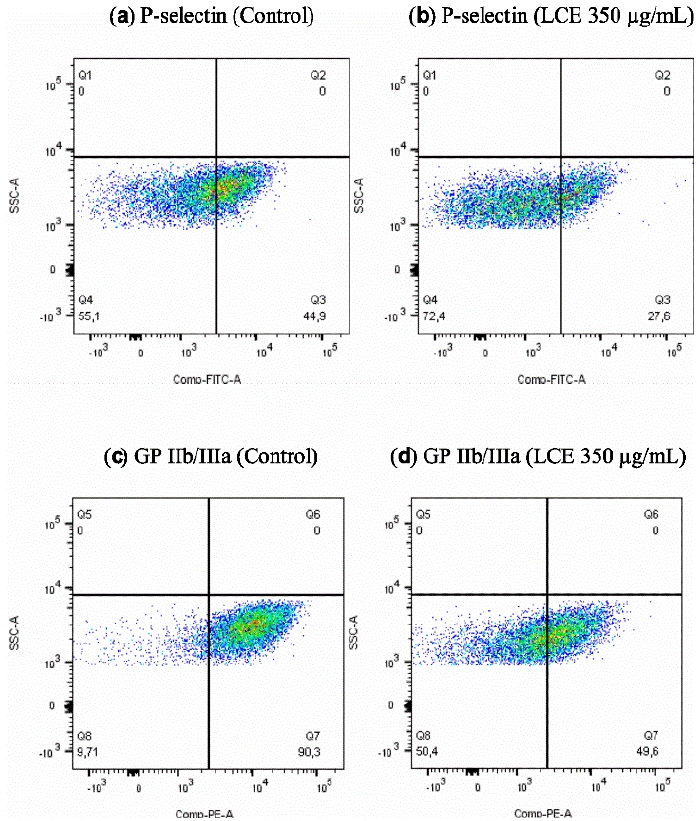
Figure 8. Representative dot plots for flow cytometry analysis. ( a ), ( c ) Control: P-selectin and GP IIb/IIIa expression on platelet surface after ADP activation. ( b ), ( d ) P-selectin and GP IIb/IIIa expression on platelet surface after ADP activation preceded by platelets co-incubation with L. cardiaca L. extract (LCE) used at 350 µg/mL.